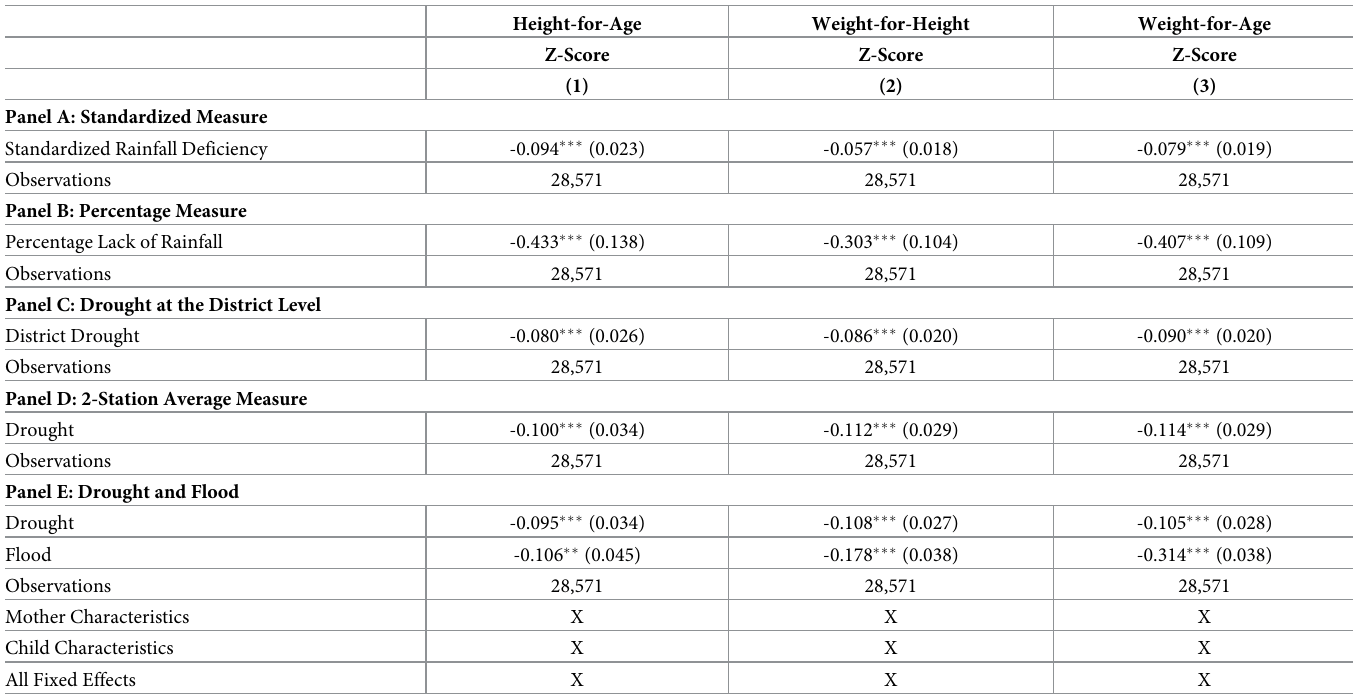
Table 7. Prenatal exposure to droughts and child health—Other